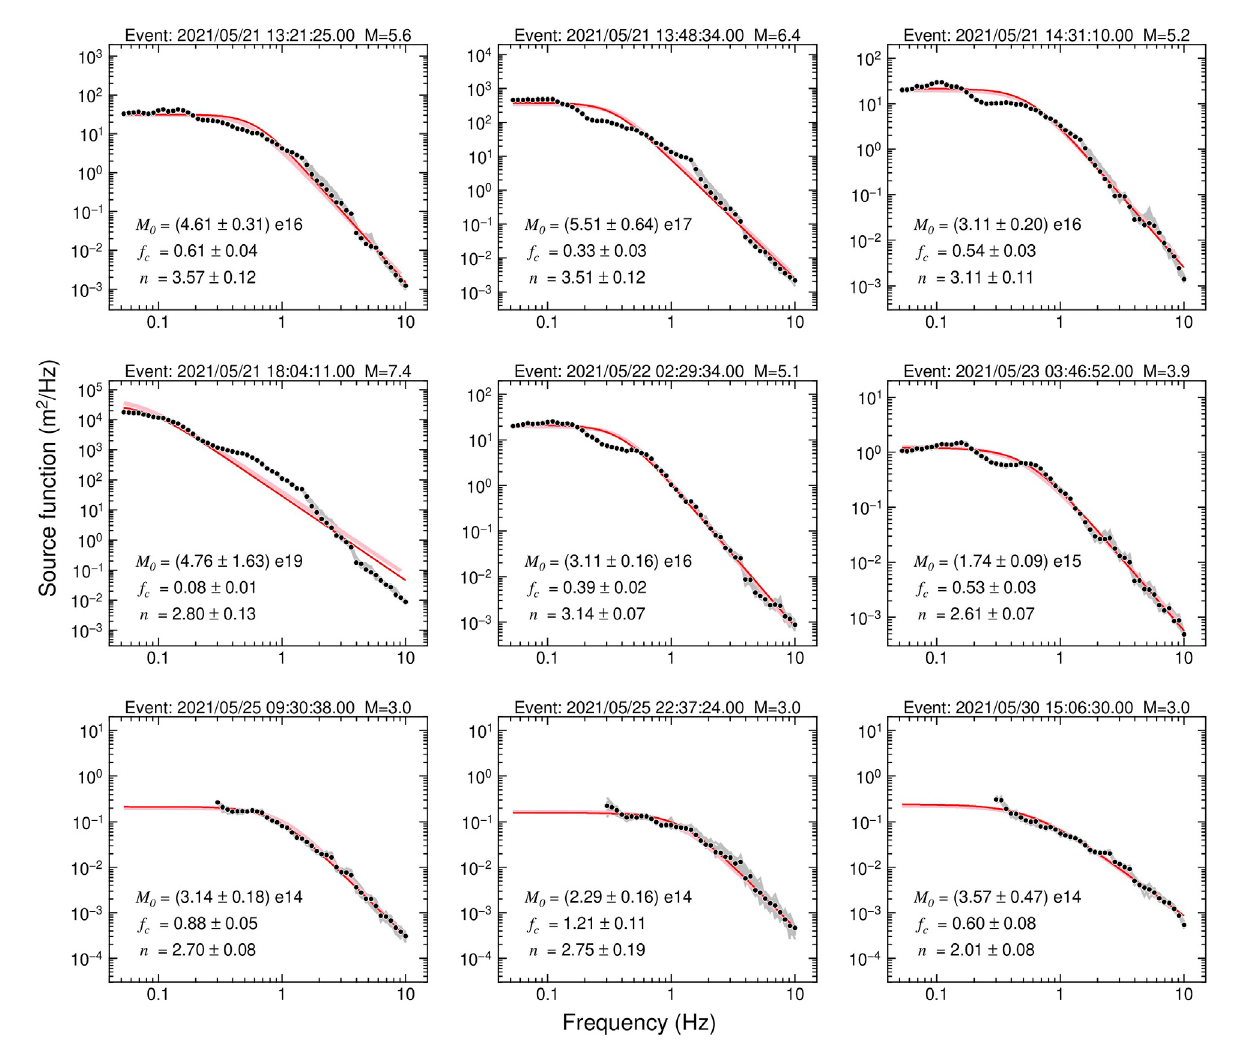
FIGURE 7 Illustrationsofretrievedsourcespectra(blackcircles)andestimatedsourcemodels(redlines).Forearthquakeswithmagnitudeslessthan3.5,thesource models fi t only the spectra above 0.3 Hz. Gray and pink lines represent the source spectra obtained using 80% randomly sampled data and corresponding sourcemodels,respectively. Ineachpanel,theearthquakeinformation,scalarseismicmoment,